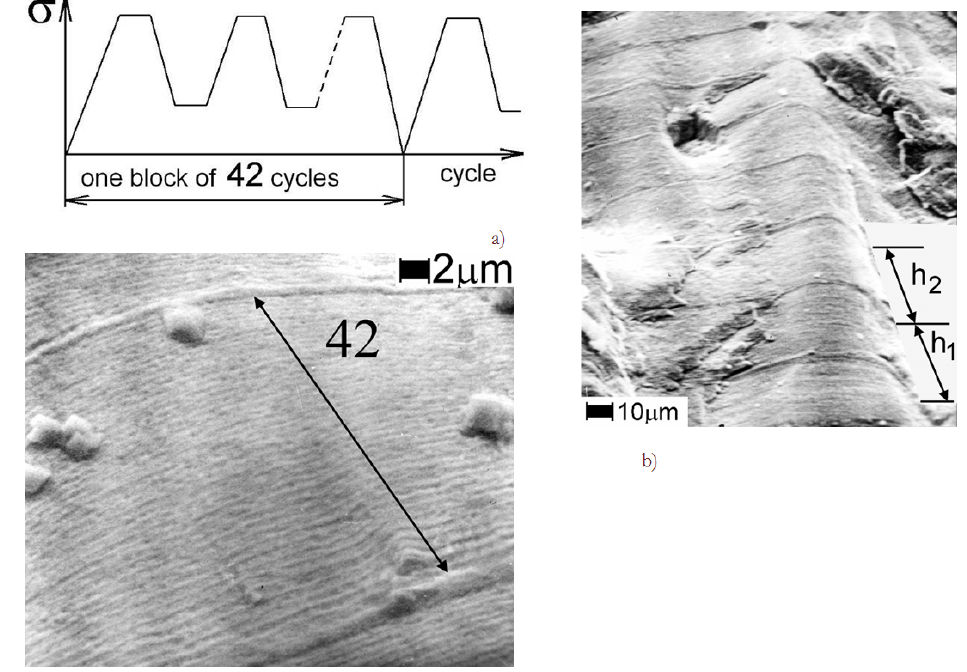
Figure 8: (a) Block of loading waveform (schematic) of a Stage III turbine disk applied when bench-testing an NK8-2u engine and (b, , illustrating the fracture response of the disk loaded in the c) fatigue-striation blocks, h i